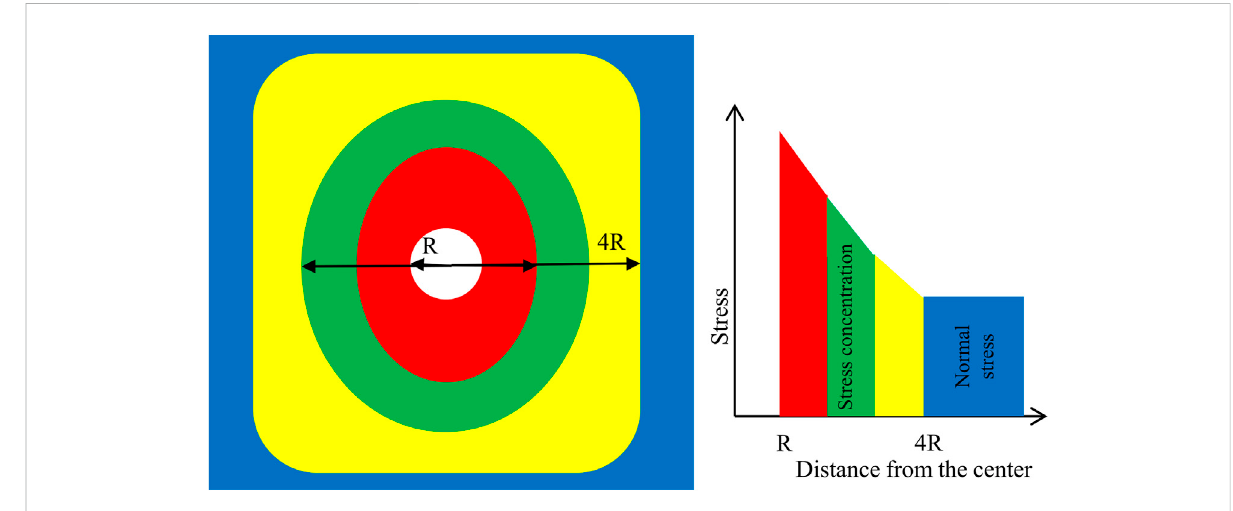
FIGURE 9 Schematic diagram of stress distribution in the SC area.